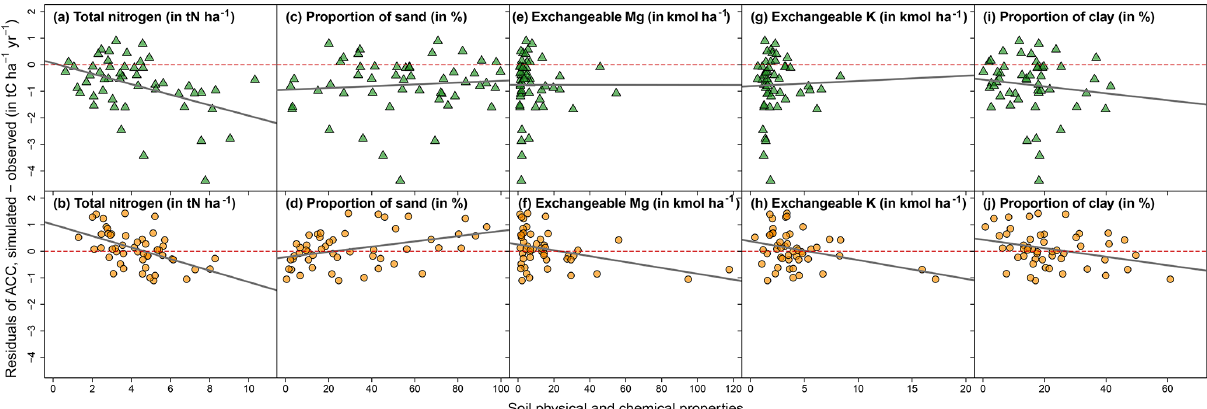
Figure 5. Residuals of annual carbon stock change (ACC) plotted against selected soil physical and chemical properties. Top plots with green triangles represent sites dominated by conifers, and bottom plots with orange dots represent sites dominated by broadleaves. Regressions in all five subplots for the broadleaved sites (b, d, f, h, j) and in one subplot for the stands dominated by conifers (a) are significant ( ∗ P< 0 . 5). See Table S2 for linear regression results for all 11 soil variables. Red dashed line indicates the zero line.